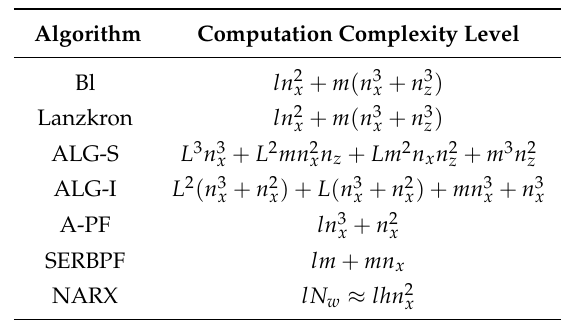
Table 1. Computation complexity levels of OOSM algorithms: n x is the element number; l is the delay number; the maximum permitted delay is L ; m is the number of measurements; N w is the number of total weights in the nonlinear autoregressive model with exogenous inputs (NARX) neural network; p i is the number of elements in each